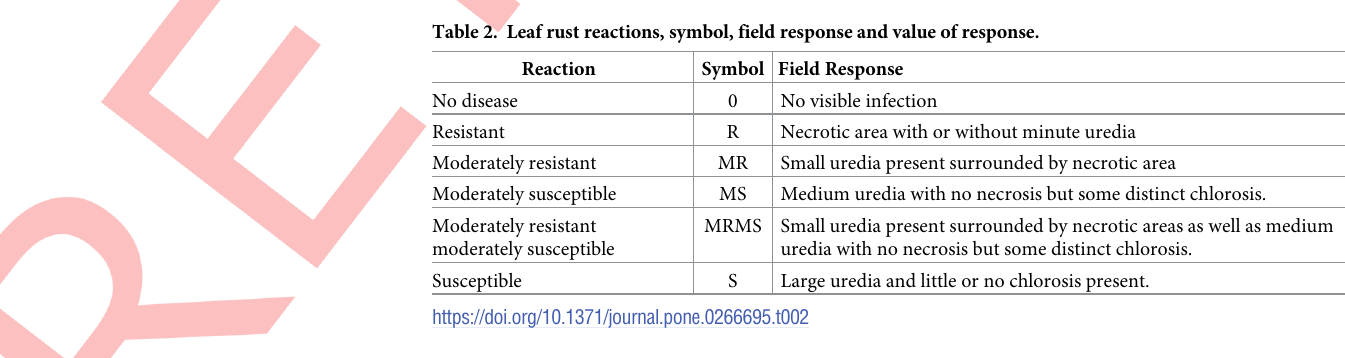
Table 2. Leaf rust reactions, symbol, field response and value of response.